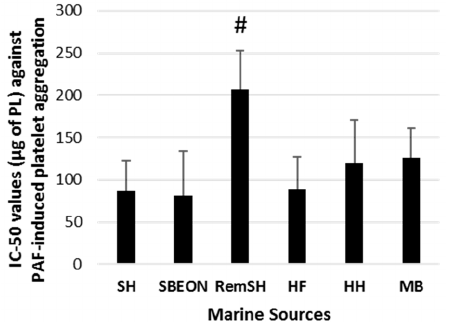
Figure 1. Antithrombotic activities of PL extracts from salmon, herring, and boarfish by-products against platelet-activating factor (PAF)-induced aggregation of human platelets. Results are expressed as IC 50 (half-maximal inhibitory concentration) values that reflect the inhibitory strength of each PL extract against PAF-induced platelet aggregation and is expressed as mean values of µ g of PLs in the aggregometer cuvette that causes 50% of inhibition of PAF-induced aggregation of platelets in